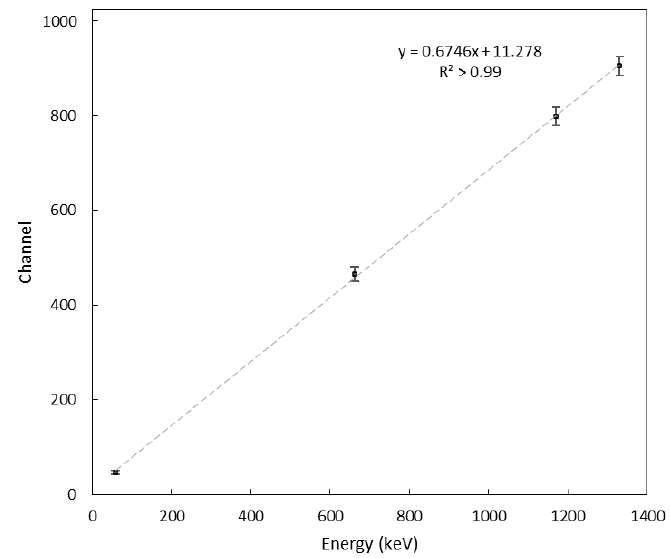
Figure 10. Energy calibration results, showing satisfactory linearity for the SiPM readout of the CsI(Tl) crystal. Non-linearity at lower energies may result from low energy non-linearity observed during charge calibration, but it is also consistent with expectations for CsI(Tl).